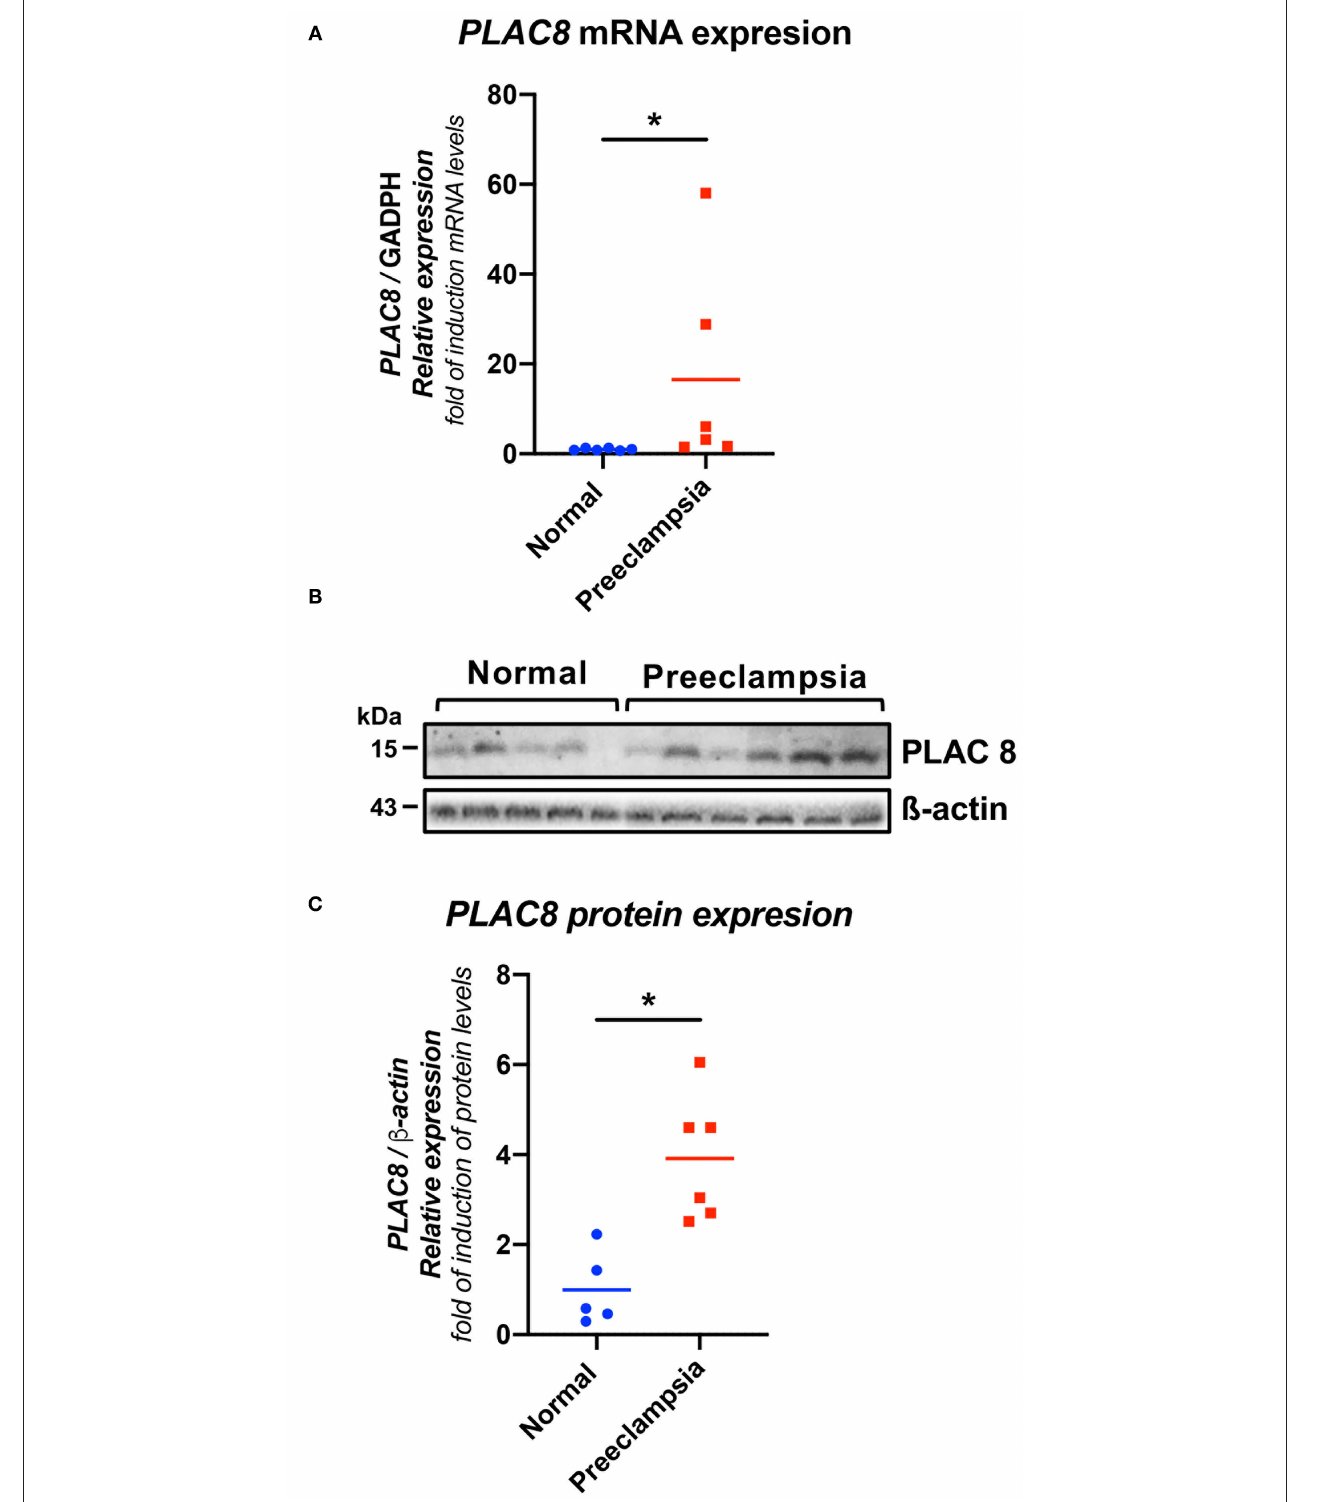
FIGURE 1 | PLAC8 gene and protein abundance in human placentas from healthy pregnancies and preeclampsia. (A) Real-time PCR analysis of PLAC8 expression in normal and preeclamptic placentas. Gene expression levels were normalized to GAPDH . Samples: normal ( n = 6), preeclampsia ( n = 6). (B) Representative western blot for PLAC8 in protein extracts from villous tissue. (C) PLAC8/b-actin protein densitometries of western blotting. b-actin was used as a loading control. Samples: normal ( n = 5), preeclampsia ( n = 6). Data presented as means ± SD. Normal in color blue, PE represented in red Student’s t -test. * p < 0.05.